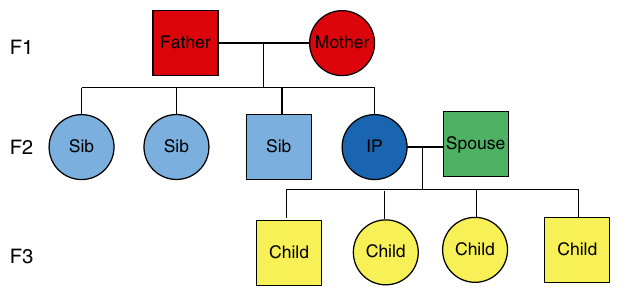
Fig. 1 Conceptual pedigree of a 3 fi lial (F) generation family in the study. This fi gure represents a hypothetical family from the UPDB or LINKS covering 3 fi lial (F) generations. Circles represent women, squares represent men. Dark blue: index persons (F2), red: parents (F1), light blue: siblings of IP (F2), green: spouses of IP (F2), yellow: children of IP (F3).